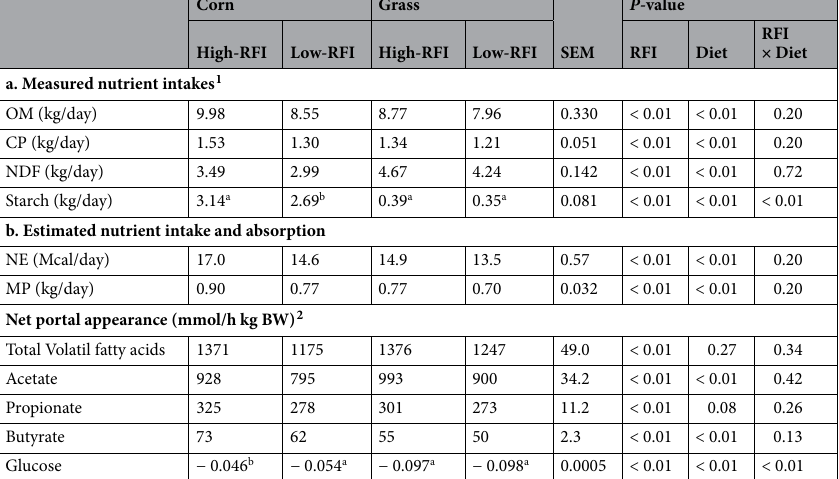
Table 1. Nutrients intake and absorption in high versus low residual feed intake (RFI) young bulls fed corn- or grass-silage diets. a,b: Means are compared only within each diet. Different letters means significant differences according to Tukey test ( P < 0.05). 1: Measures based on DMI and diet composition, OM Organic matter intake, CP Crude protein, MP Metabolizable protein, NDF Neutral detergent fibre, NE Net energy. 2: Estimated according to Loncke et al. 63